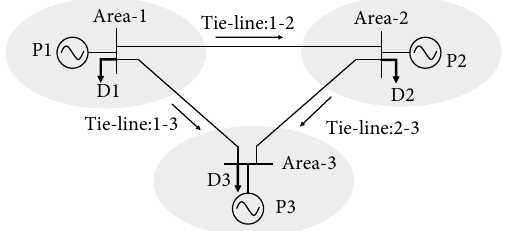
Fig. 8 The Bus-3 test